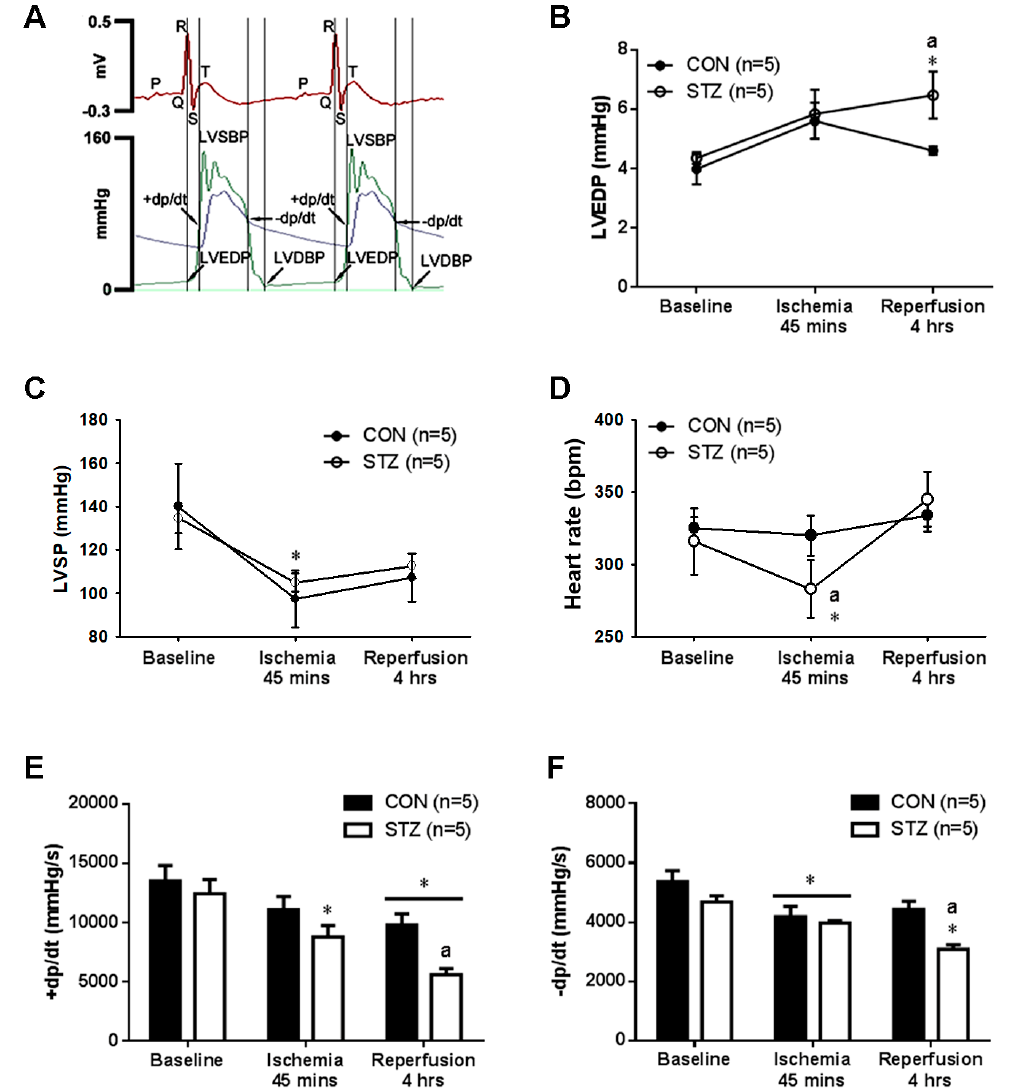
Figure 3. The myocardial ischemia/reperfusion (IR) effect on several cardiac parameters in CON and STZ rats. The original graphs on left ventricular pressure tracing are shown in one CON rat ( A ). In response to myocardial IR injury, the increased left ventricular end-diastolic pressure (LVEDP) ( B ) during the reperfusion stage, the decreased left ventricular systolic pressure (LVSP) ( C ) and heart rate ( D ) during the ischemic period and the decreased value of +dp/dt ( E ) and − dp/dt ( F ) are noted in the 5 STZ rats as compared with the 5 CON rats. * p < 0.05 vs. CON, a p < 0.05 vs. STZ.